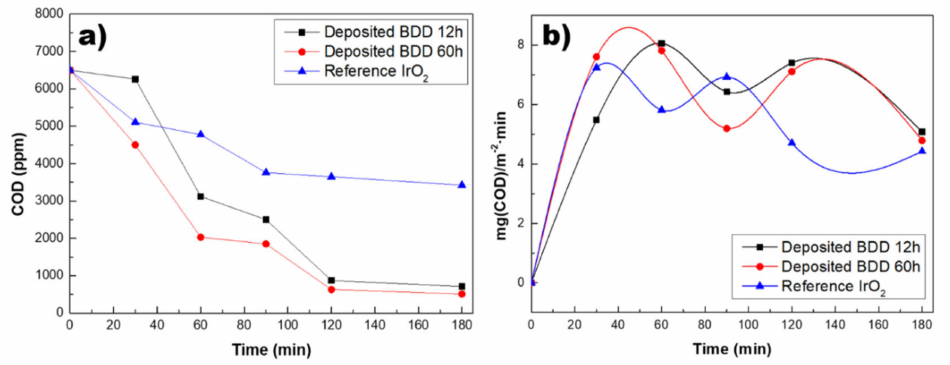
Figure 6. Evaluation of change in ( a ) chemical oxygen demand (COD) and ( b ) degradation rate by BDD